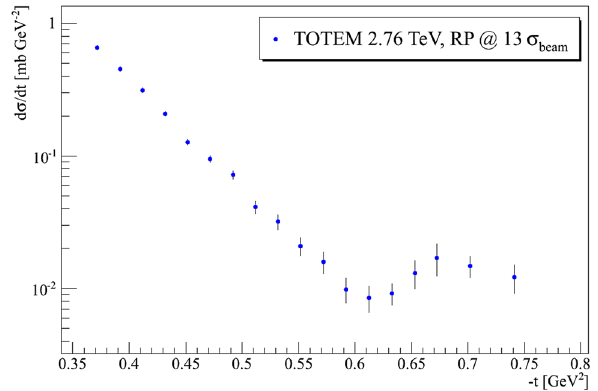
Fig. 8 The pp differential elastic cross section d σ/ d t of DS1 at 2 . 76 TeV